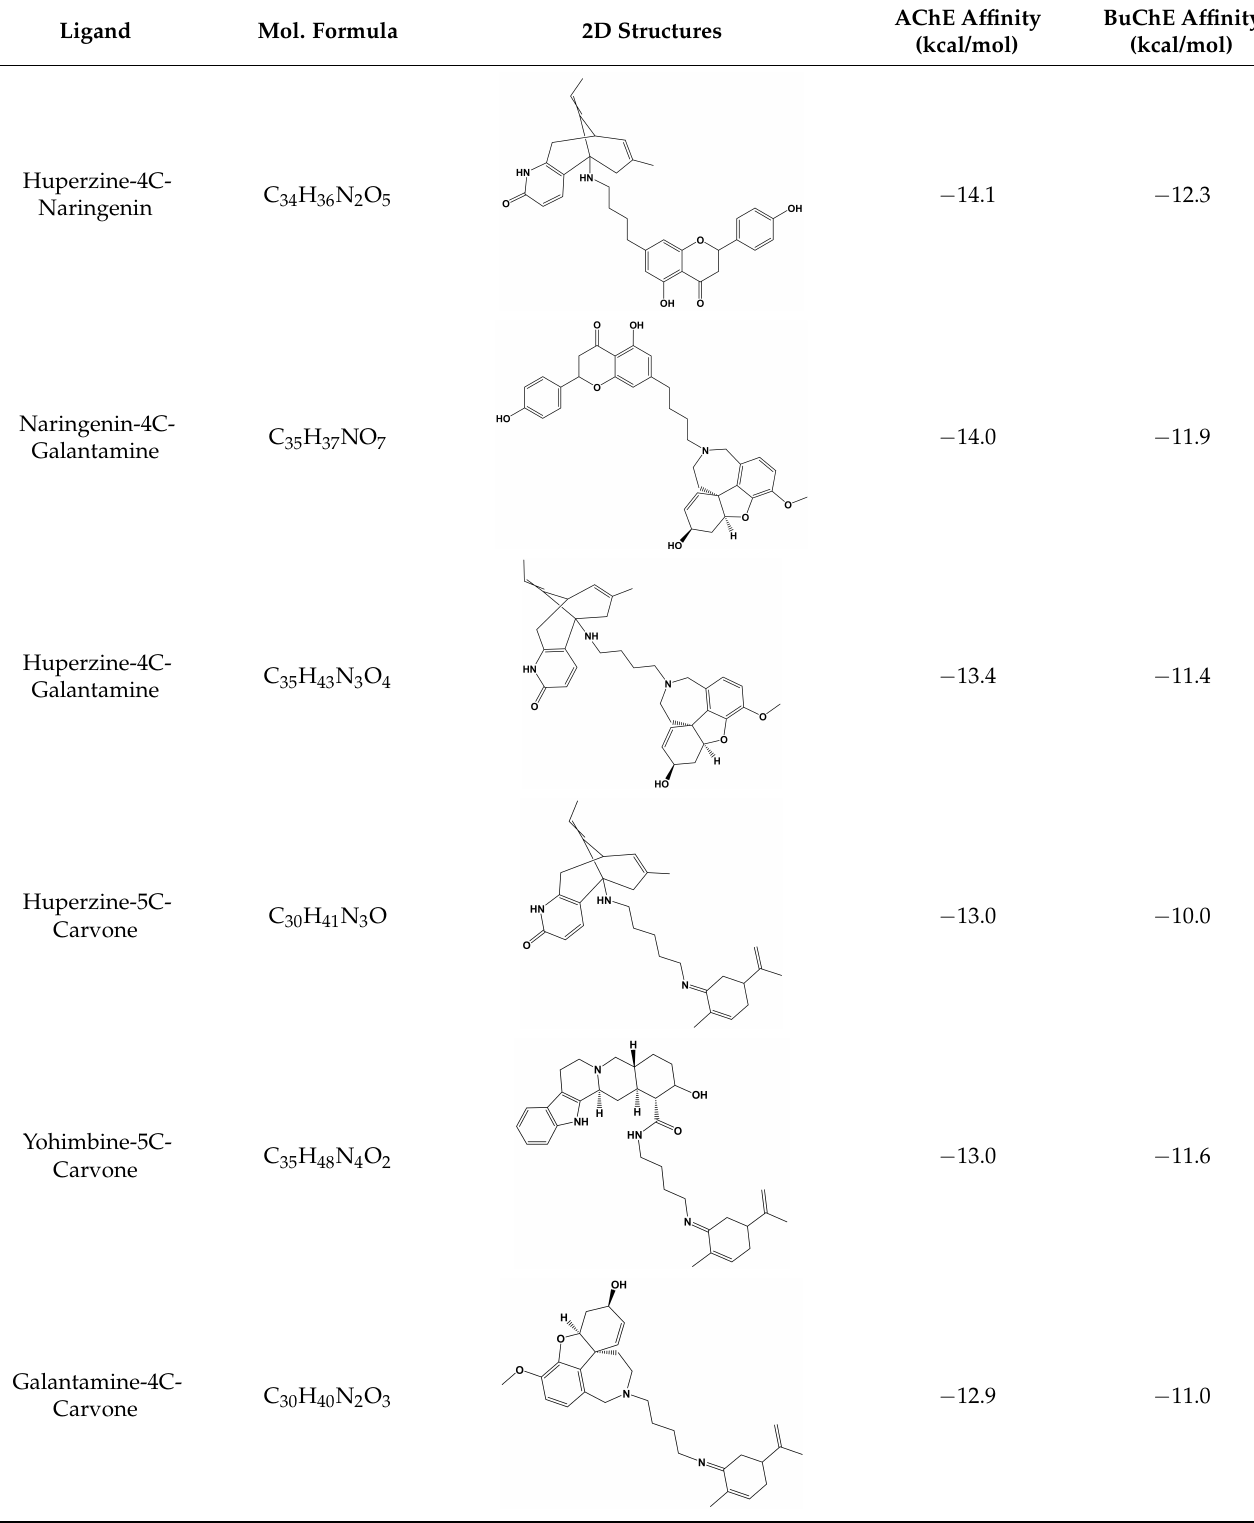
Table 2. Dual-binding site heterodimers of potent phytochemicals with anti-cholinesterase